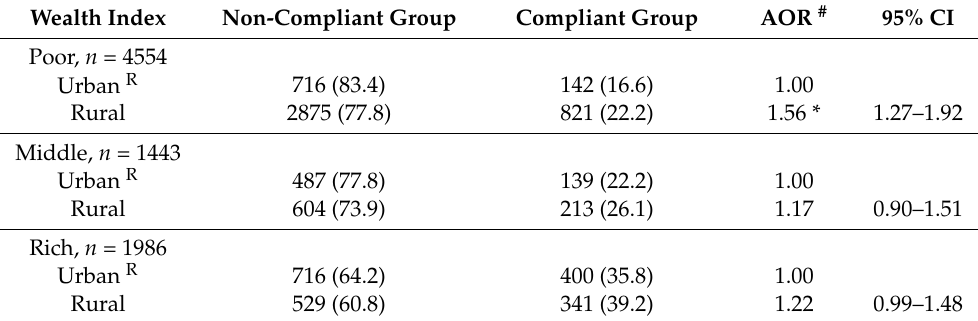
Table 3. The association between residence and iron-folic acid supplementation compliance across different wealth